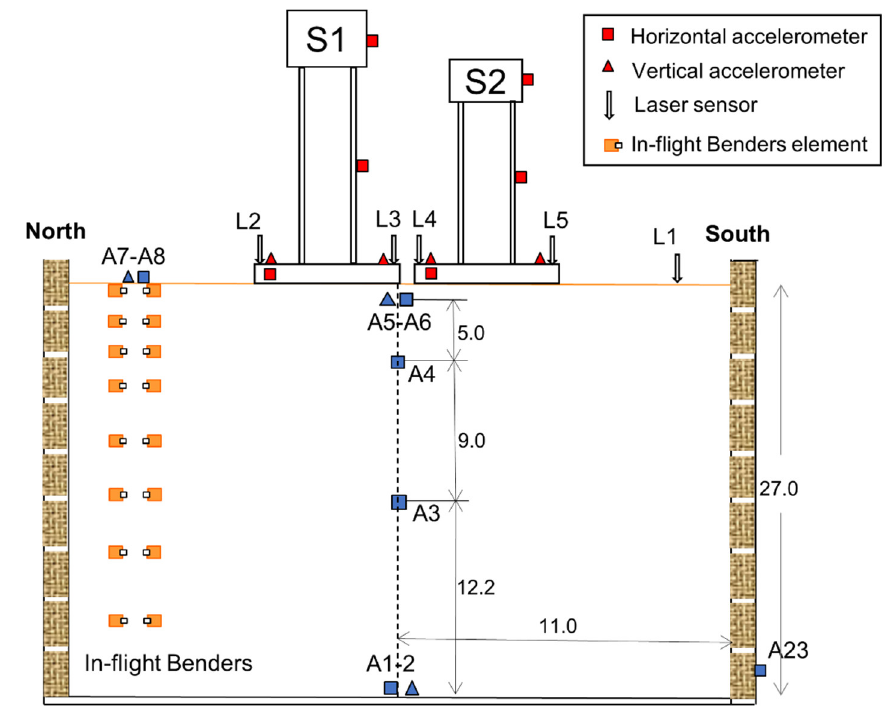
Figure 1. Schematic drawing of typical centrifuge models for S1‐S2 structures in case of 0.03B distance with installation of in‐flight bender elements, accelerometers, and laser sensors. Accelerometers installed in soil are marked in blue while those bonded at structure are indicated as red.